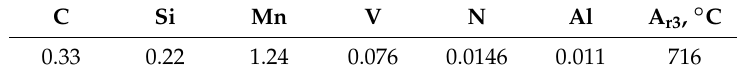
Table 1. Chemical composition (mass %) and transformation critical temperature (A r3 , 0.2 K/s). C Si Mn V N Al A r3 , ◦ C 0.33 0.22 1.24 0.076 0.0146 0.011